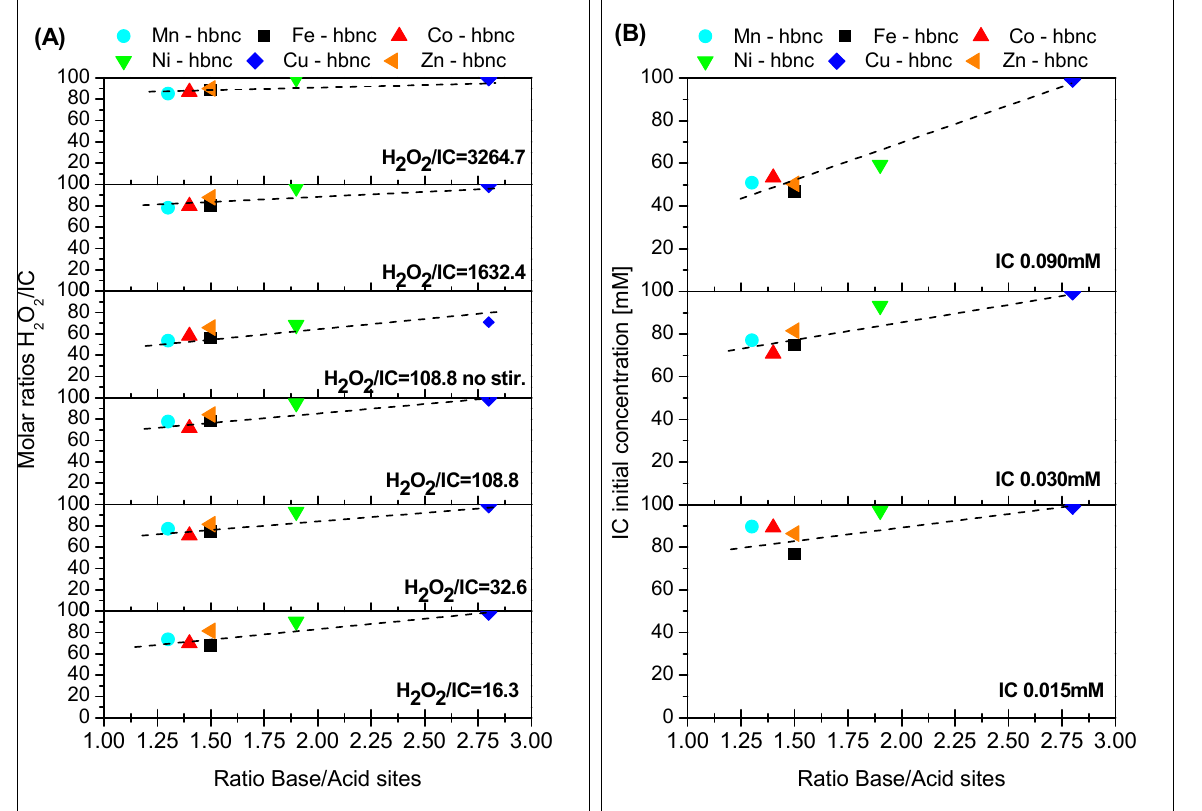
Figure 6. Linear correlation of the DR % and the ratio base/acid sites in the catalyst samples (( A )— IC initial concentration 0.03 mM, 25 °C, 2 h, 150 rpm, 1 wt% catalyst; ( B )—molar ratio H 2 O 2 /IC = 32.6, 25 °C, 2h, 150 rpm, 1 wt% catalyst).